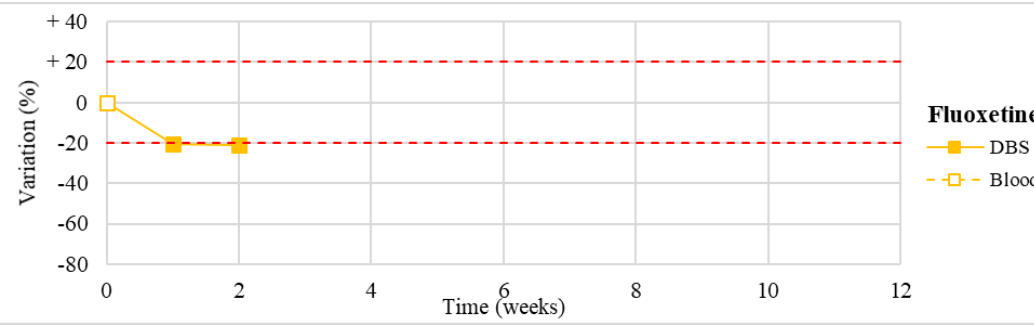
Figure 11. Stability of fluoxetine ( n = 1) in DBSs stored at room temperature and in blood stored at − 20 ◦